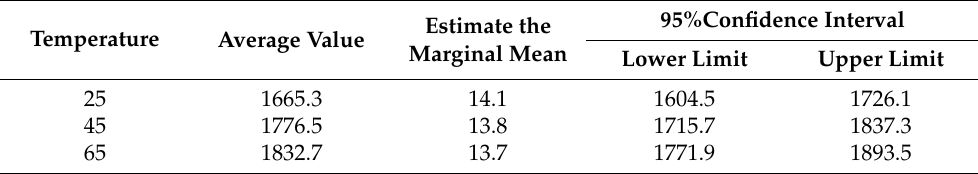
Table 7. Analysis of the effect of humidity factors on the shrinkage of 28-day foamed concrete. Estimated Humidity Average Value